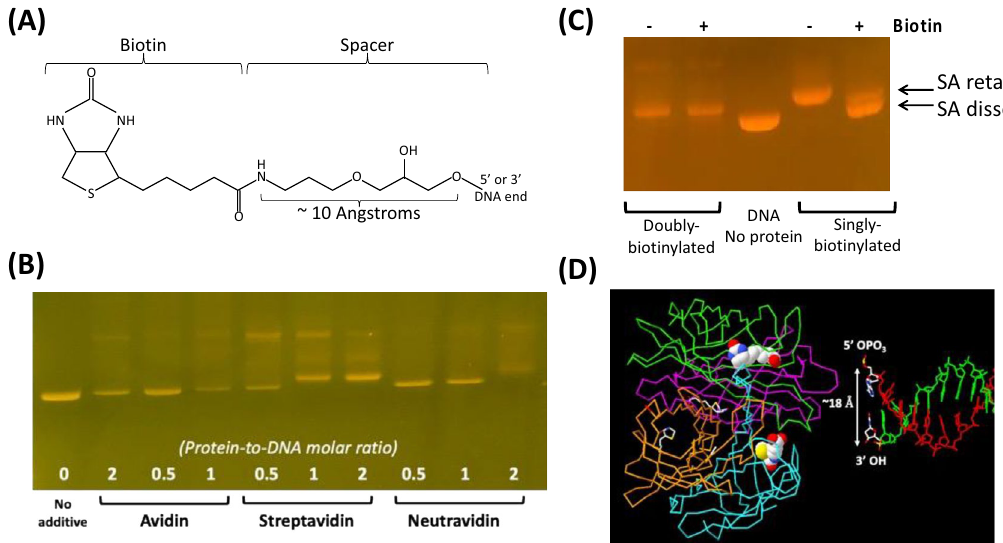
Figure 2. Synthesis and characterization of blocked-end linear DNA. ( A ) Structure of the 5’ end of biotin- labeled linear DNA 17 , ( B ) Agarose gel electrophoresis showing the formation of DNA–protein complexes using three different biotin-binding proteins: avidin, streptavidin and neutravidin. Bound complexes migrate slower compared to unbound DNA. The numbers indicate protein-to-DNA molar ratio, which varied from 0.5 to 2 for each protein. In the streptavidin-bound complexes, the DNA species that migrates slightly slower than the linear DNA alone (leftmost lane) presumably has a streptavidin tetramer bound to each end, while the most slowly migrating species may be a relaxed circle that is held together by a single streptavidin tetramer. ( C ) An agarose gel showing the dissociation of streptavidin (SA) from blocked-end DNA complexes where the DNA has